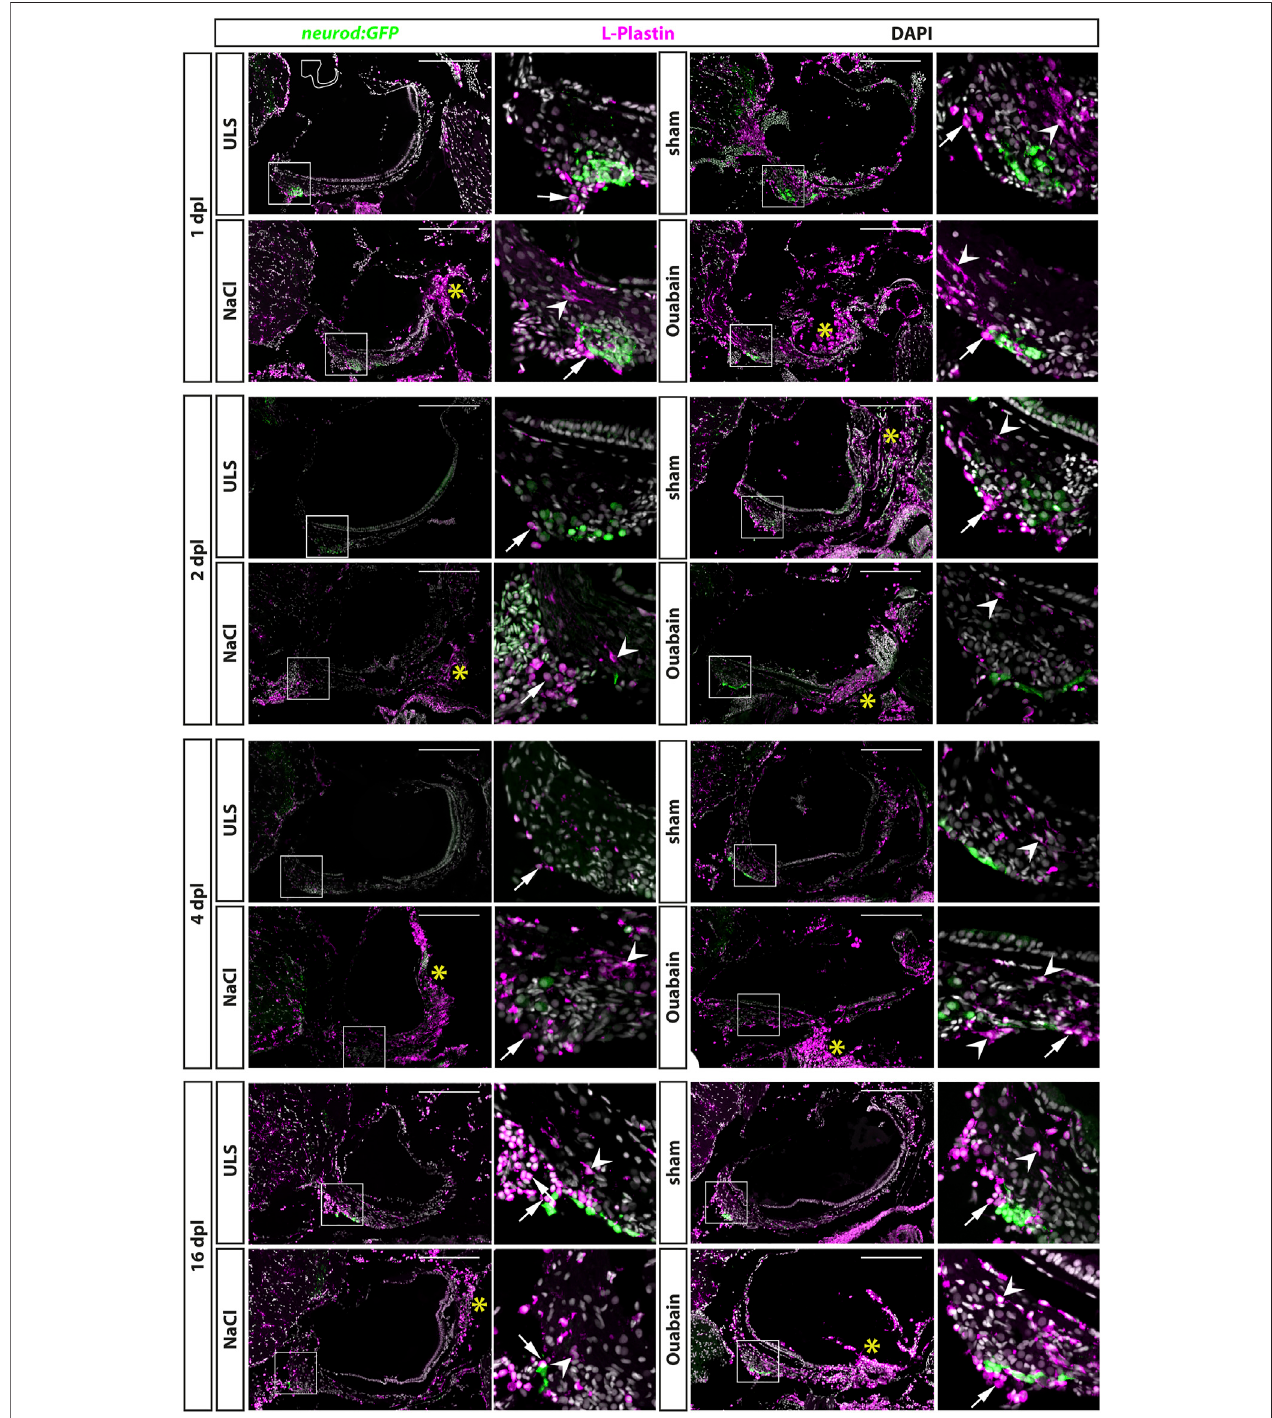
FIGURE3| Accumulationofleukocytesintheadultzebra fi shSAGuponlesion.Antibodystainingagainstthepan-leukocytemarkerL-plastinandGFPintheSAGof transgenic neurod :GFP zebra fi sh at 1, 2, 4, and 16 days post lesion (dpl). Shown are representative images of the SAG following sham-treatment, or NaCl or ouabain injectionsaswellastheunlesionedside(ULS)ofeithersham-treated,orNaCl-orouabain-injectedanimal.Boxesshowclose-upsoftherespective neurod :GFP-positive neurogenicniche.Intheunlesionedside(ULS,upperleftpanelineachtimepoint),afewrami fi edL-plastin-positivecellsaredistributedevenlythroughouttheentire SAG.Someround, strong L-plastin-positivecellsarelocalizedinclosecontact totheneurogenicnicheontheventralsideoftheSAG(arrows). Incontrast,accumulation of rami fi ed L-plastin-positive cells (arrowheads) in the SAG isobserved close to the neurogenic niche at all time points within sham-treated, or NaCl- or ouabain-injected SAGs(upperrightandlowerpanelsineachtimepoint).Inaddition,thedensityofL-plastin-positivecellsisusuallythehighestatthedistalpartoftheSAG,especiallywhen the sensory patch is massively destroyed as, for example, seen in 1 dpl/NaCl and ouabain, 2 dpl/ouabain, and 16 dpl/ouabain, irrespective of the lesion type (yellow asterisks). Scale bars: 200 µm.